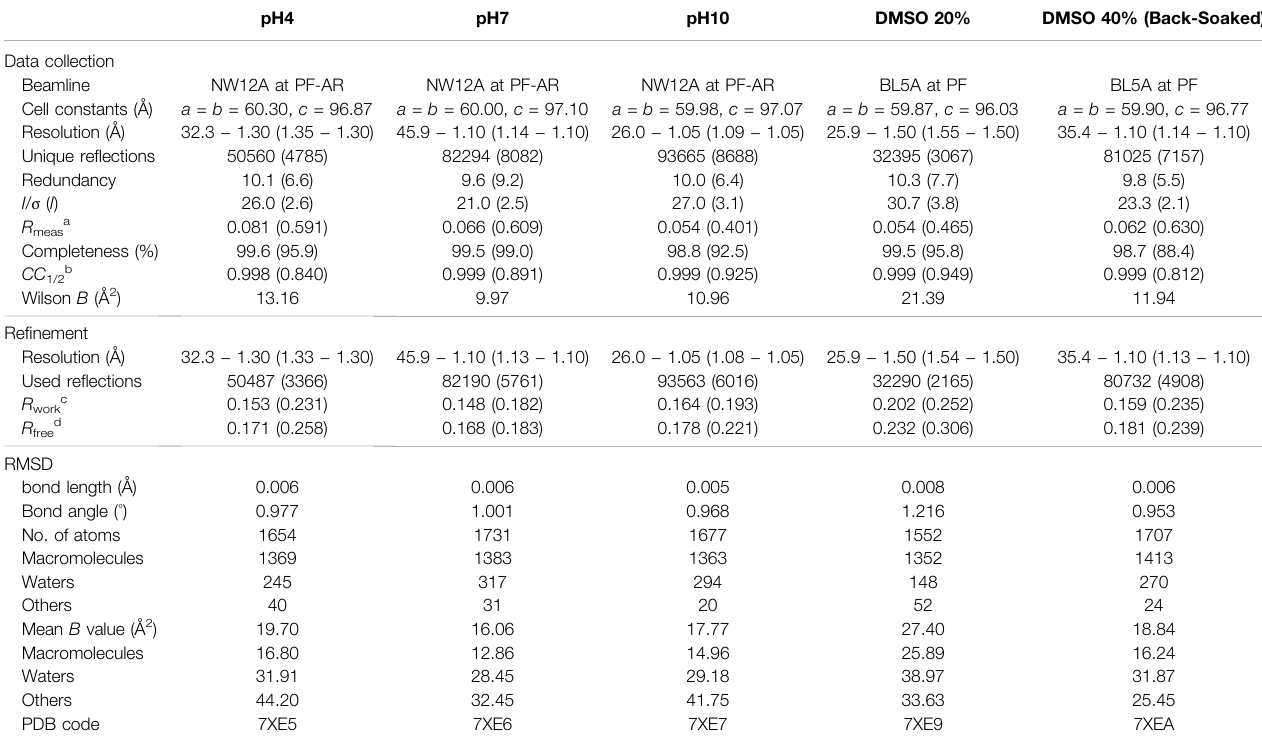
TABLE 1 | Data collection and re fi nement statistics for the SNAT-T4L mutant in different buffer conditions. The statistics for the highest-resolution shell are presented in parentheses. pH4 pH7 pH10 DMSO 20% DMSO 40% (Back-Soaked) Data collection